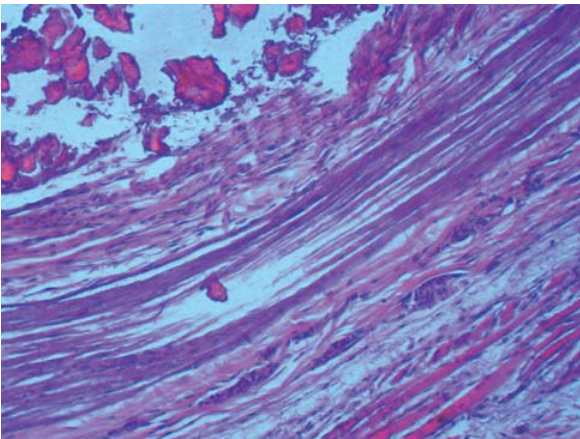
FIGURE 4- Demonstrative image of condensation fibrosis when using distilled water at 30